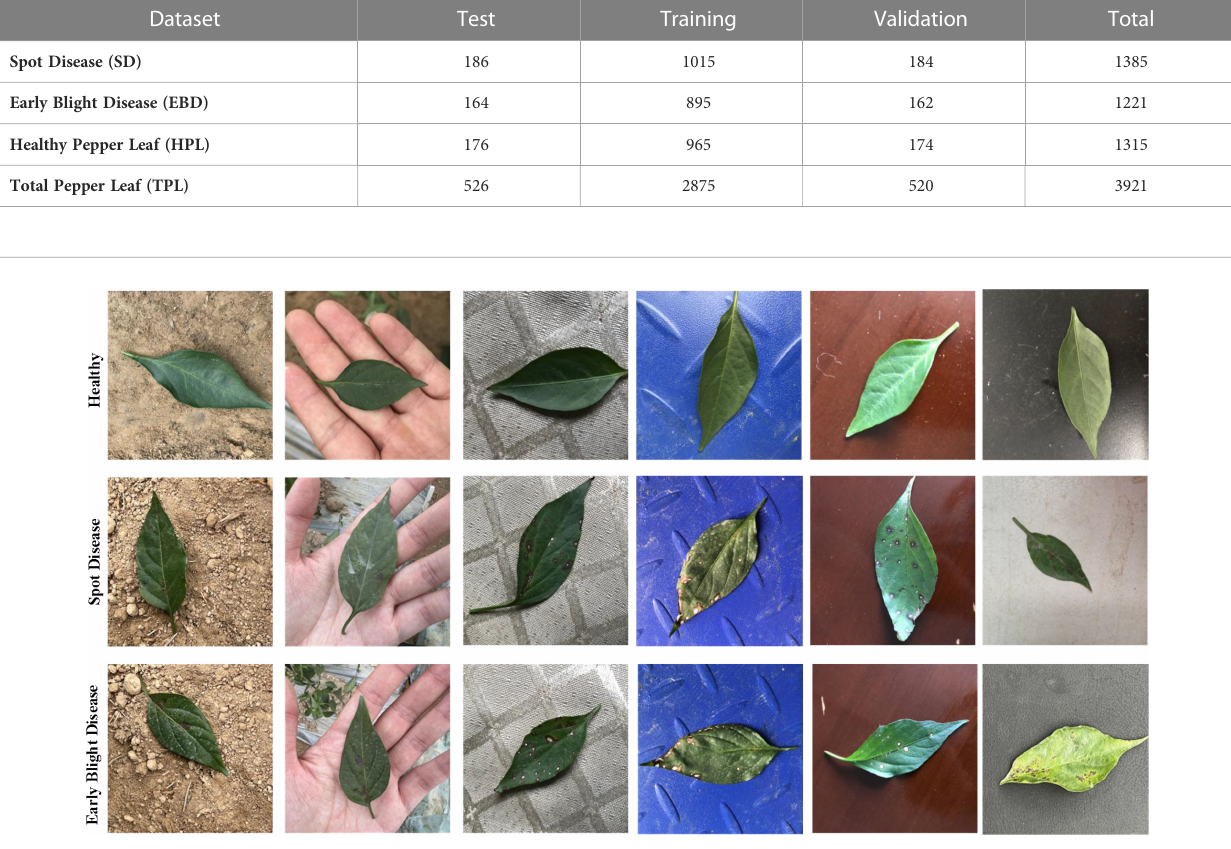
TABLE 2 Four datasets for the validating the proposed model on the pepper leaf.